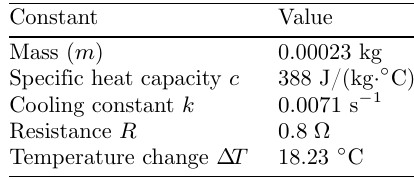
Table 1. Values of the constants used in the